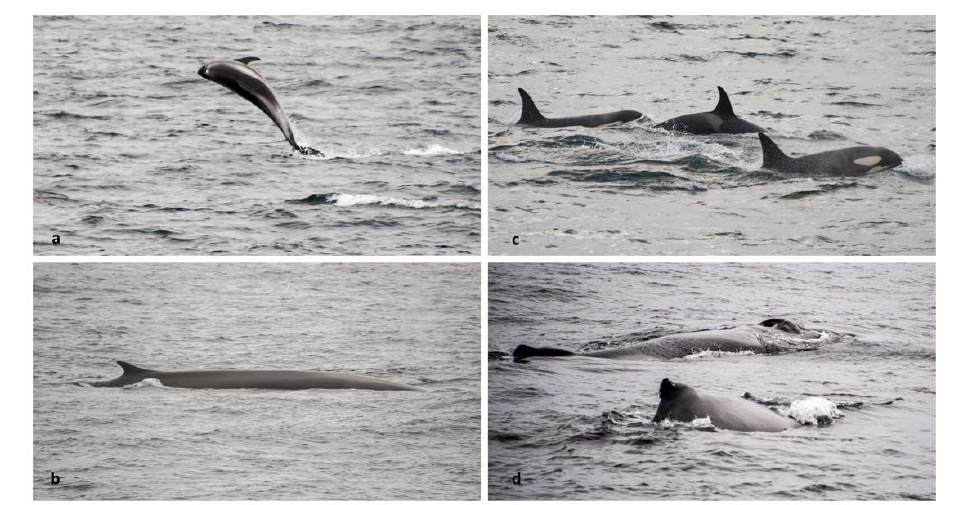
Figure 1. (a) White-beaked dolphin, (b) Fin whale, (c) Killer whales, and (d) Humpback whales. Photo credit: Deanna